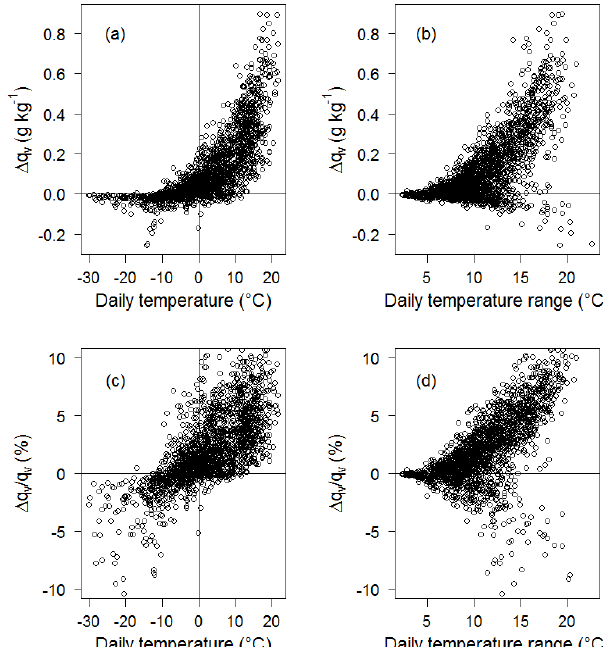
Figure 2. Relation between (cid:49)q v and (a, c) daily mean temperature and (b, d) daily temperature range. (cid:49)q v is the difference in specific humidity calculated from daily mean T and RH ( q vd ) and from the mean of hourly q v data ( q vh ): (cid:49)q v = q vd − q vh . The top panels are actual differences, in gkg − 1 , and the lower panels are normalized by q vd , expressed as the percent